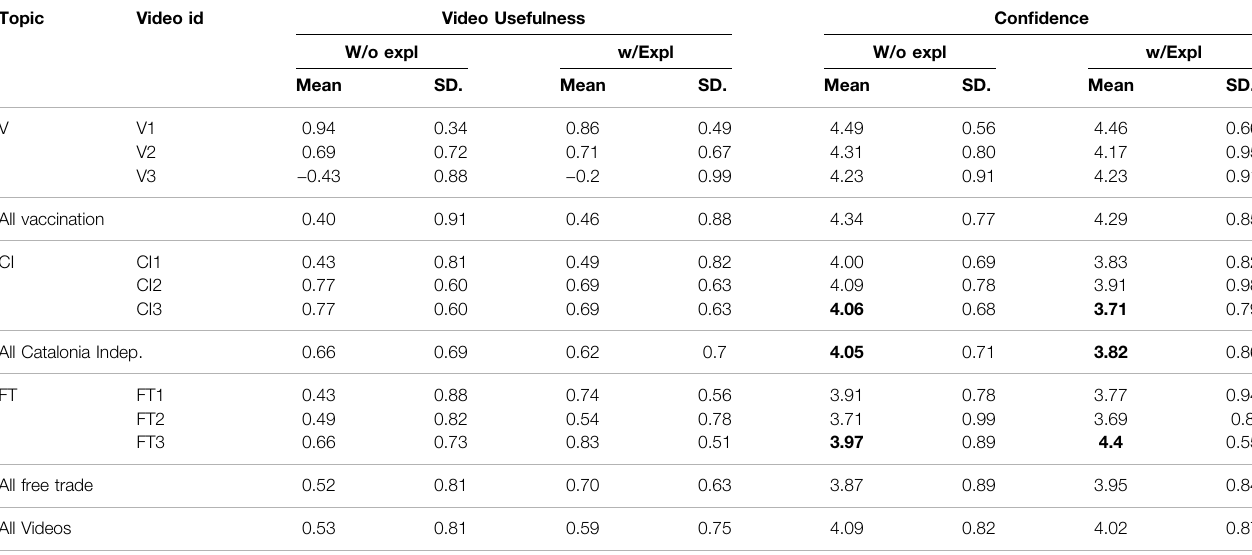
TABLE 5 | Mean and SD for variables video usefulness and con fi dence, in the conditions without and with explanations. Topic Video